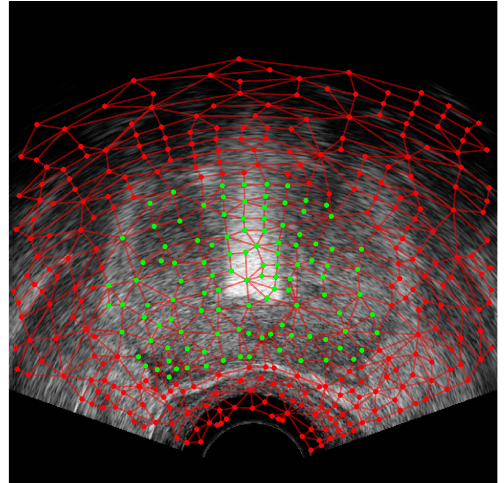
Figure 10. Superpixel regions after graph-cut procedure. The centroids of regions labelled as being inside of the prostate, R k ∈ L In , are displayed with green dots, and the centroids of the superpixel regions outside of the prostate, R k ∈ L Out , are displayed with red dots.